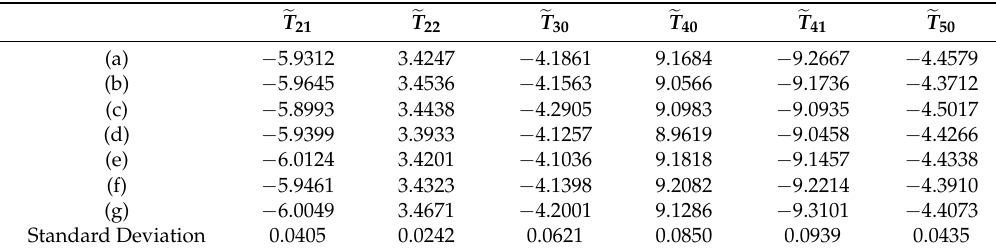
Table 4. Tchebichef moment invariants of the images in Figure 7.